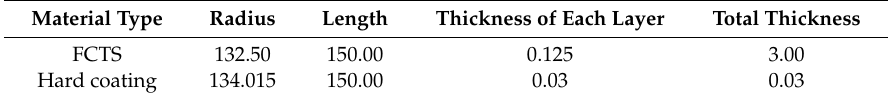
Table 1. The geometry properties of FCTS and hard coating (mm).